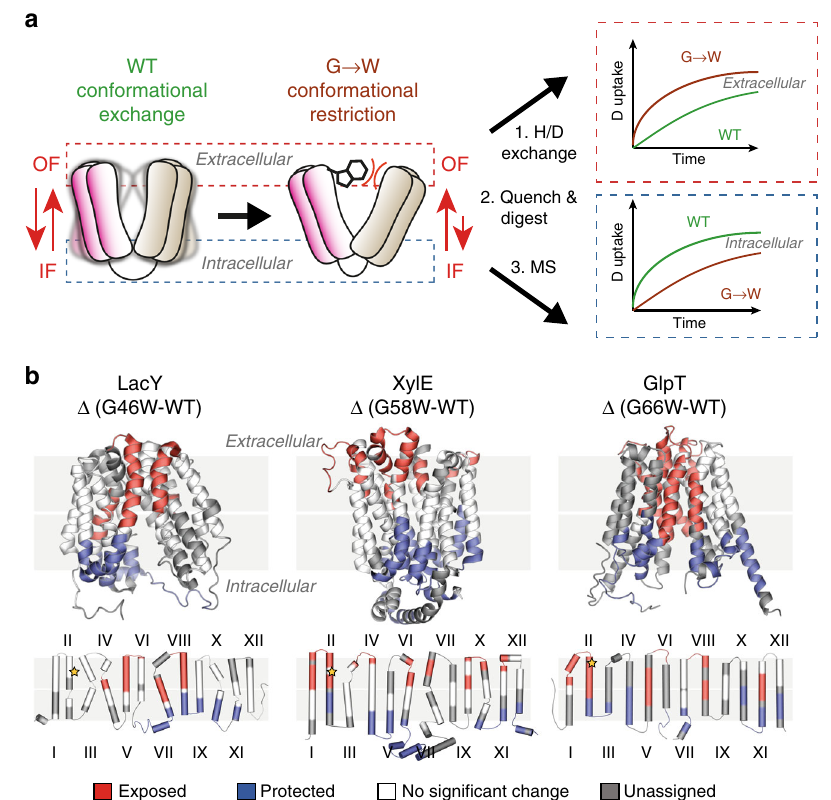
Fig. 1 HDX-MS reports on changes in the conformational equilibrium between IF and OF states. G to W mutants were used to highlight shifts in the conformational equilibrium. a Introduction of a tryptophan at the extracellular end of helix 2 sterically prevents closing. After deuteration, enzymatic digestion, and identi fi cation of the peptides by MS the mass uptake of the WT and mutants is compared. Peptides located on the intracellular side will be on average more deuterated than the peptides located on the extracellular side for the mutant (top graph) while the opposite pattern will be observed for the WT (bottom graph). b Differential deuterium uptake pattern ( Δ HDX) mapped onto the 3D and topological structure of LacY (PDB: 2V8N), GlpT (PDB: 1PW4), and XylE (PDB: 4GBY). Red and blue colored regions indicate segments containing peptides with a positive Δ HDX (red — more deuteration) or negative Δ HDX (blue — less deuteration), respectively; white regions indicate that no signi fi cant Δ HDX is observed ( P ≤ 0.01), and gray indicates regions where peptides were not obtained for both the mutant and the WT conditions. The yellow star indicates the location of the point mutation. All measurements were performed in triplicates. The Δ HDX datasets are presented as Woods plots in supplementary Figs.12 and